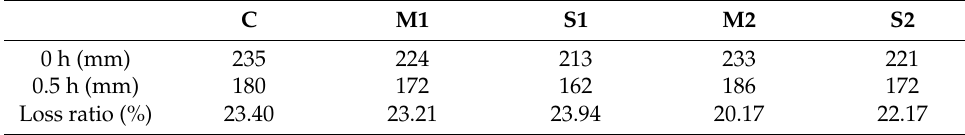
Table 3. Slump and slump loss of fresh